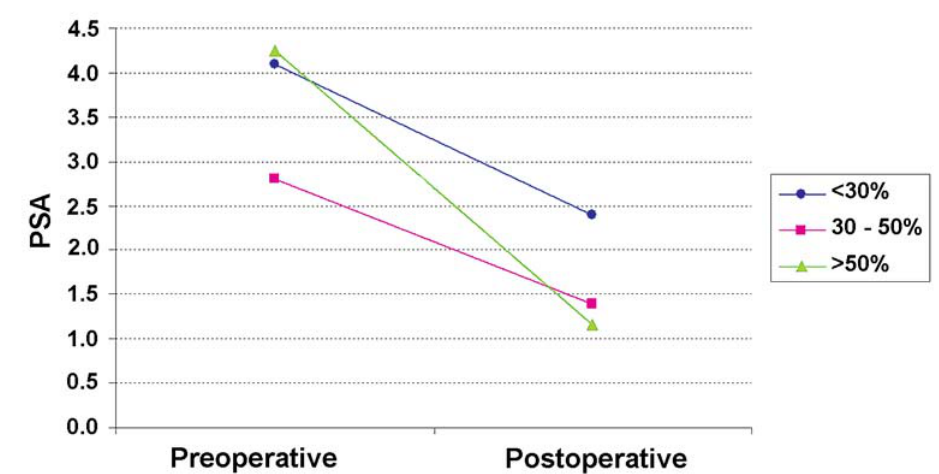
Figure 4 – Variation in PSA according to percentage of resected